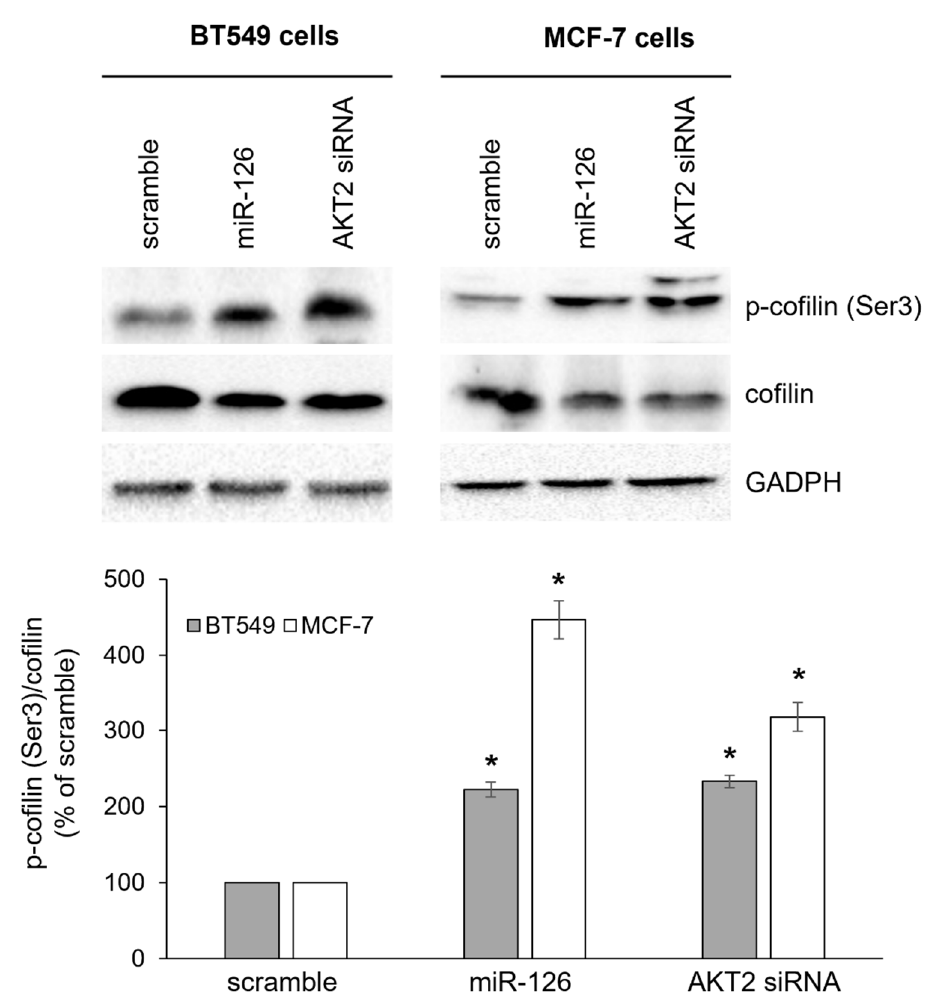
Figure 4. miR-126-3p/AKT2 axis decreases cofilin activity. BT549 and MCF-7 cells were left untreated (NT) or transiently transfected with scramble oligo (scramble), miR-126-3p mimic (miR-126), or AKT2 siRNA before investigating the expression of total and phosphorylated (Ser3) cofilin by Western blot. Histogram shows densitometric analysis; values are reported as p-cofilin (Ser3)/total cofilin ratio compared to scramble-transfected cells (not statistically differing from NT cells), arbitrarily set to 100%. GAPDH was used as loading control. Blots are representative of five independent experiments and results are reported as mean ± SEM. *: p < 0.01 versus scramble.